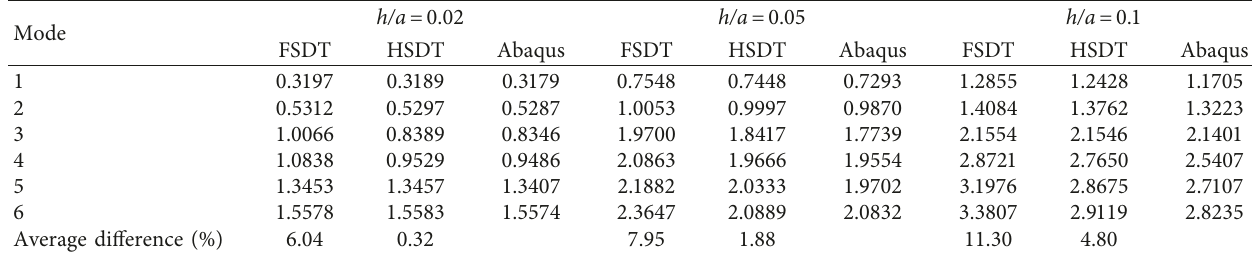
� 40, G � G 2 / E 1 12 / E 2 13